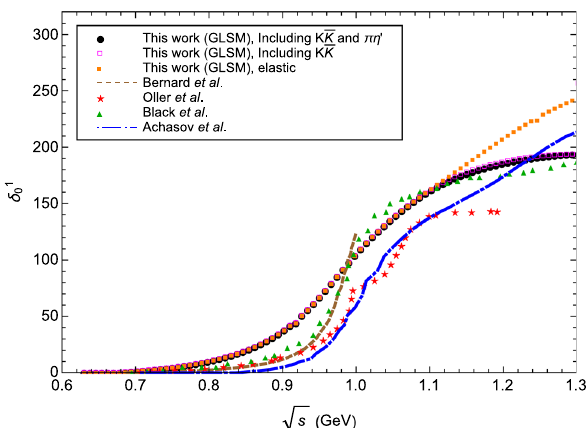
Fig. 18 TheeffectoftheinelasticchannelsontheS-wave πη scattering phase shift is compared with the phase shift computed in the elastic channel (with the specific inputs A 3 / A 1 = 30 and m [ π( 1300 ) ] = 1 . 38 GeV), as well as with the predictions by Bernard et al. [147], Oller et al. [155], Black et al. [138] and Achasov et al. [150]. Including the inelastic channels moves the phase shift closer to the predictions of [138,150,155] above 1 . 1 GeV